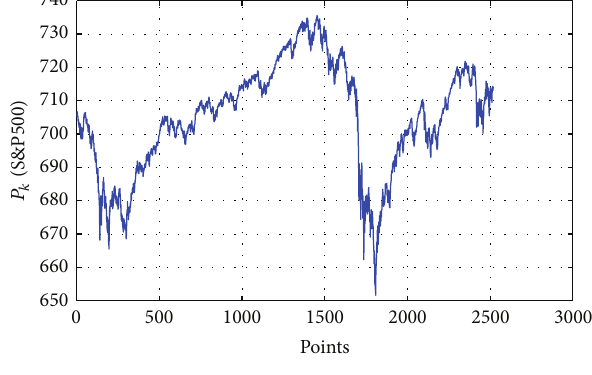
Figure 6: S&P500 time series 𝑃 𝑘 .